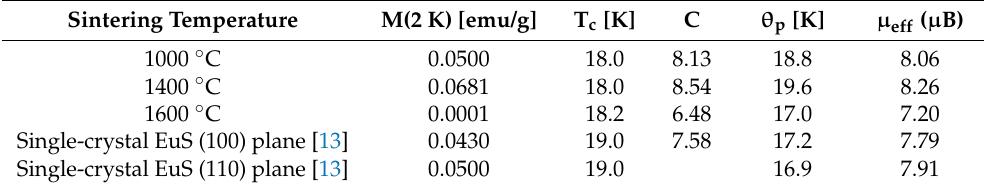
Table 2. Magnetization at 2 K, Curie temperature (T c ), and Curie parameters of EuS sintered at temperatures in the 1000–1600 ◦ C